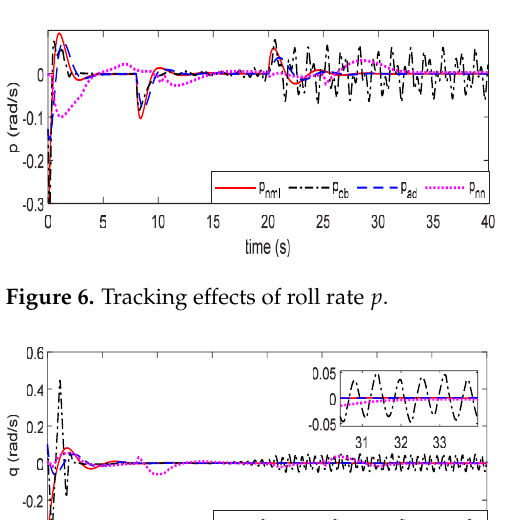
Figure 5. Tracking effects of sideslip angle β .